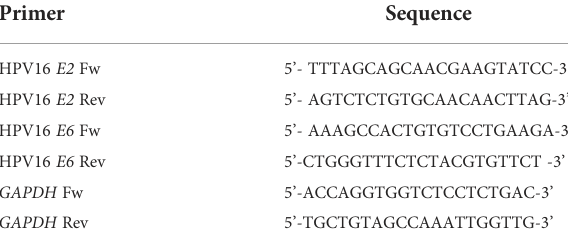
TABLE 1 Primer sequence used for E2 , E6 and GAPDH qPCR.